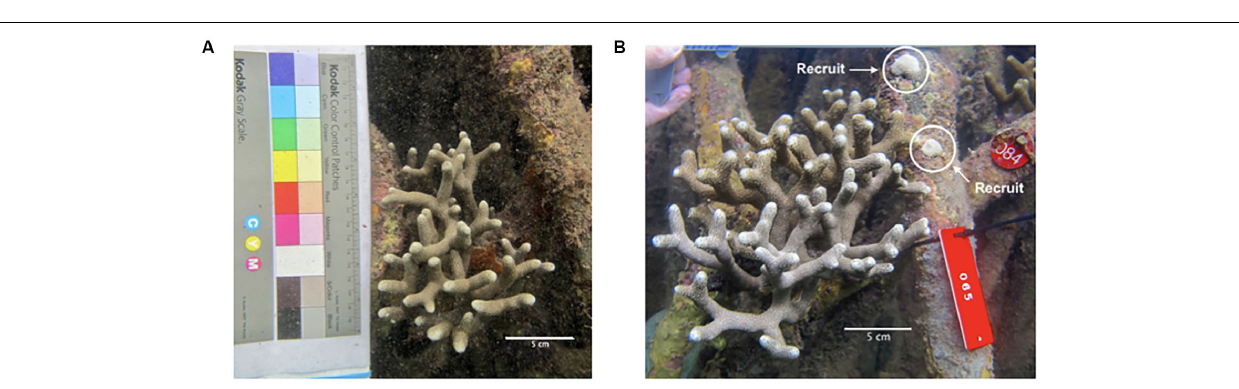
FIGURE 10 | New recruits located adjacent to a resident colony. A representative photograph of a larger resident colony in 2016 (A) that was found the following year (2017) with recruits that settled within inches of the branches (B)